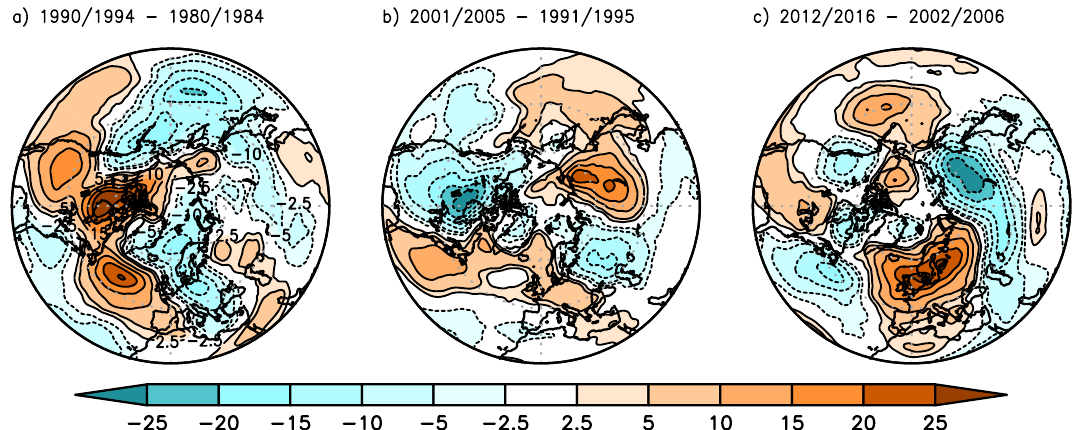
Figure 5. Trend-like pattern determined by the difference of 5-year means of ZATO for